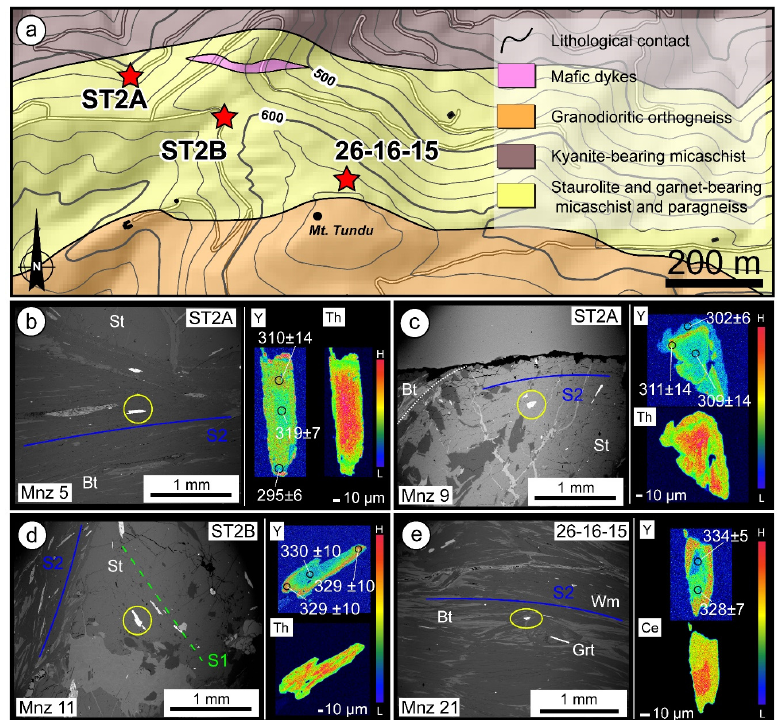
Figure 8. ( a ) Location of the three selected samples for geochronological analysis on the geological sketch map displayed in Figure 2b. ( b – e ) Representative textural position and zoning of monazite grains selected for in situ dating. Color bar scale qualitatively points lower (L) to higher (H) Y-Th concentration, for sample ST2A and ST2B and Y–Ce concentration for sample 26-16-15. U–Pb concordant date with 2 σ uncertainties has been displayed. ( b ) Mnz5 in sample ST2A, located along the main S 2 foliation; ( c ) Mnz9 in sample ST2A, included in staurolite porphyroclast parallel the S 2 foliation; ( d ) Mnz11 in sample ST2B, included in staurolite porphyroclast, laying along the S 1 foliation; ( e ) Mnz21 in sample 26-16-15, located along the main S 2 foliation near a garnet porphyroclast.